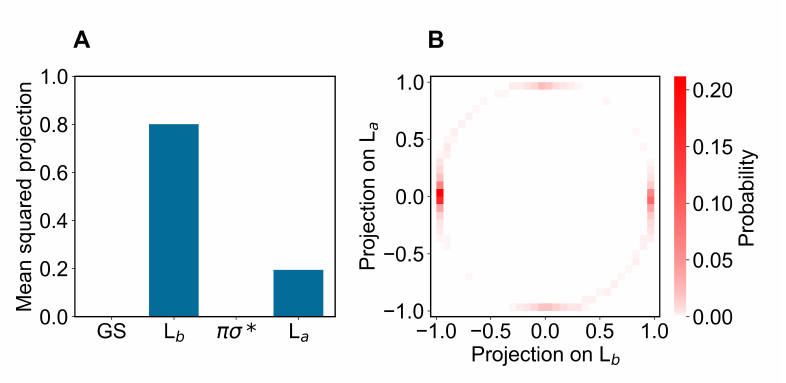
Figure 3. ( A ): Mean-squared projections of the perturbed first electronic excited state of indole, on the first four unperturbed electronic eigenstates (the ground state GS, the excited states L b , L a and the dark state πσ ∗ , in the figure ordered according to increasing energy) as obtained at the (unperturbed) ground-state geometry by the ground-state MD ensemble. ( B ): Probability distribution of the pair values of the projections of the perturbed first electronic excited state of indole, on the L b and L a states as obtained at the (unperturbed) ground-state geometry by the ground-state MD